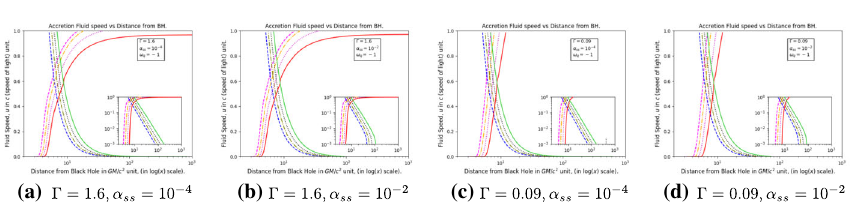
1.3 Images for λ c = 2 . 7 ,ω q = − 2 / 3 , A q = 10 − 10 . Red solid line shows wind for a = 0, Green solid line shows accretion for a = 0, Pur- ple dotted line shows wind for a = 0 . 5, Black dotted line shows accre- tionfor a = 0 . 5,Orangedash-dottedlineshowswindfor a = 0 . 9,Olive dash-dotted line shows accretion for a = 0 . 9 and Pink dashed-dashed line shows wind for a = 0 . 998, Blue dashed-dashed line shows accre- tion for a = 0 . 998. 1.4 Images for λ c = 2 . 7 ,ω q = − 1 , A q = 10 − 10 . Red solid line shows wind for a = 0, Green solid line shows accretion for a = 0, Purple dotted line shows wind for a = 0 . 5, Black dotted line shows accretion for a = 0 . 5, Orange dash-dotted line shows wind for a = 0 . 9, Olive dash-dotted line shows accretion for a = 0 . 9 and Pink dashed-dashedlineshows windfor a = 0 . 998, Bluedashed-dashedline shows accretion for a = 0 .